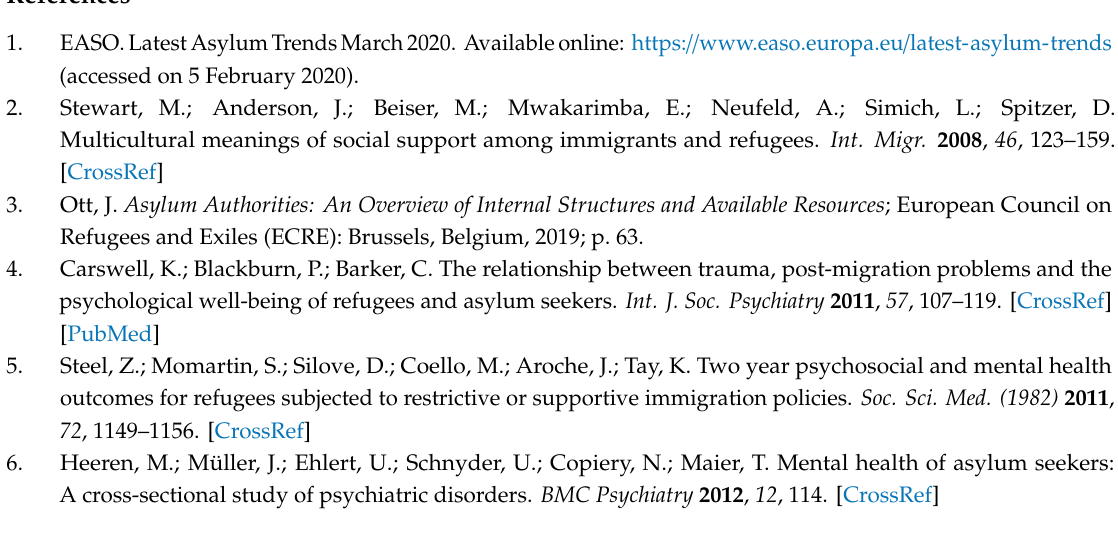
Figure S1: Hypothesized model of relationship between social and financial hardship, social support and common mental health problems among asylum